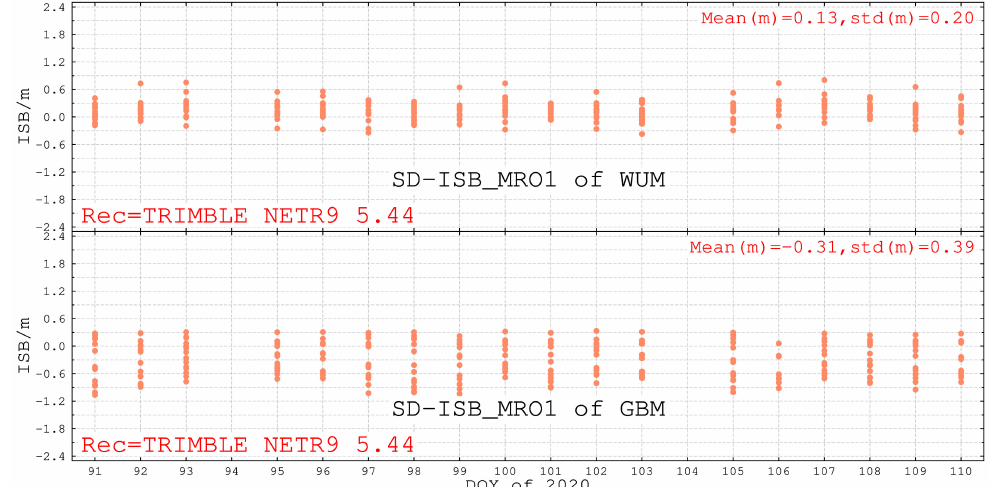
Figure 14. The single di ff erence ISB series of TRIMBLE NETR9 5.44 by using GBM and WUM precise products from DOY 091 to 110, 2020. Reference station: